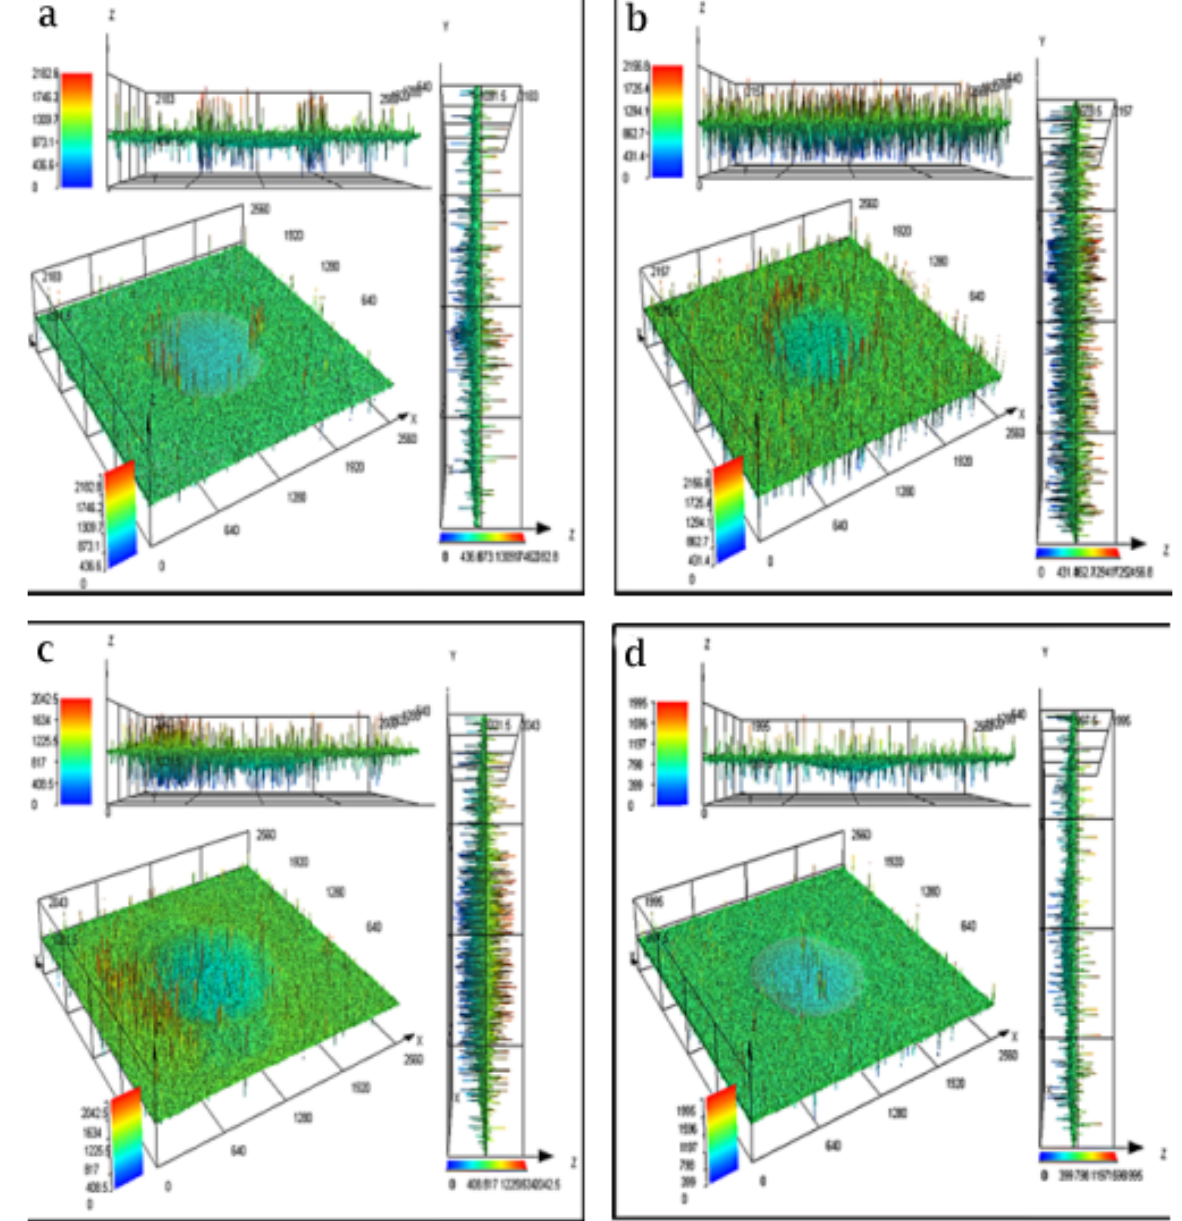
Figure 4: 3D topography of indentation: (a)Substrate; (b)NiCr coating; (c)Al 2 O 3 coating with the undercoating of NiCr; (d)Al 2 O 3 coating